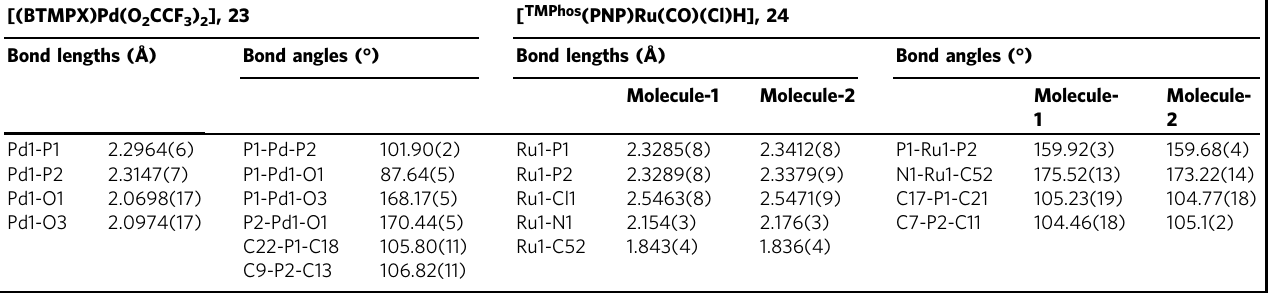
Table 1 Selected bond lengths (Å) and angles (°) of [(BTMPX)Pd(O 2 CCF 3 ) 2 ], 23, and [ TMPhos (PNP)Ru(CO)(Cl)H], 24. [(BTMPX)Pd(O 2 CCF 3 ) 2 ], 23 [ TMPhos (PNP)Ru(CO)(Cl)H],